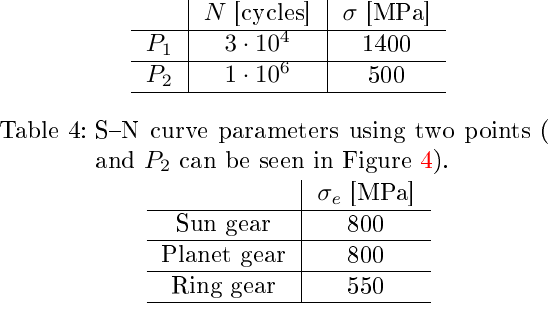
Table 5: Endurance limits for S(cid:21)N